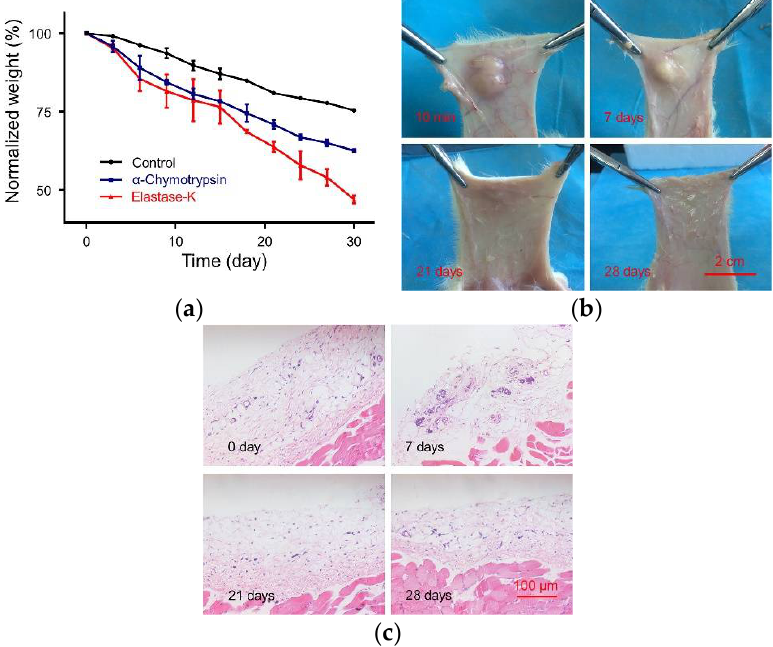
Figure 4. Degradation of hydrogel in vitro and in vivo, and histological analysis of skin. ( a ) Mass loss curves of in vitro degradation of hydrogels in PBS, and PBS with elastase-K or α-chymotrypsin (0.2 mg mL −1 ) groups; ( b ) Images of in vivo gel maintenance at 10 min, 7, 14, 21, and 28 days after the injection of 5.0 wt. % mPEG 45 −PLAla 30 hydrogels; ( c ) Hematoxylin and eosin (H&E) images of the skin tissue near the hydrogels on day 7, 14, 21, and 28, respectively.